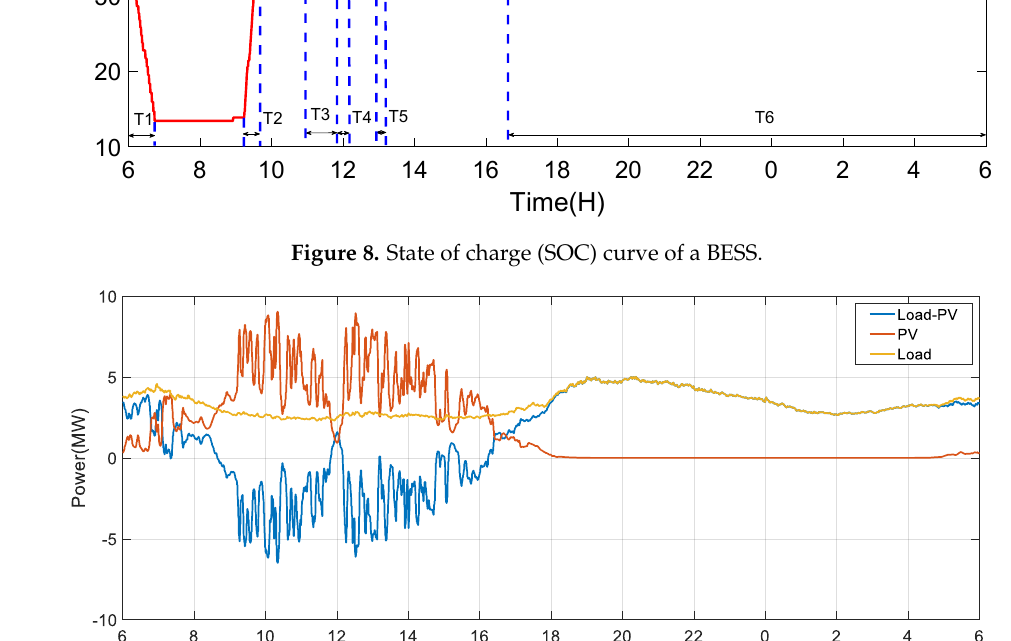
Figure 9. Daily load and photovoltaic power curves.